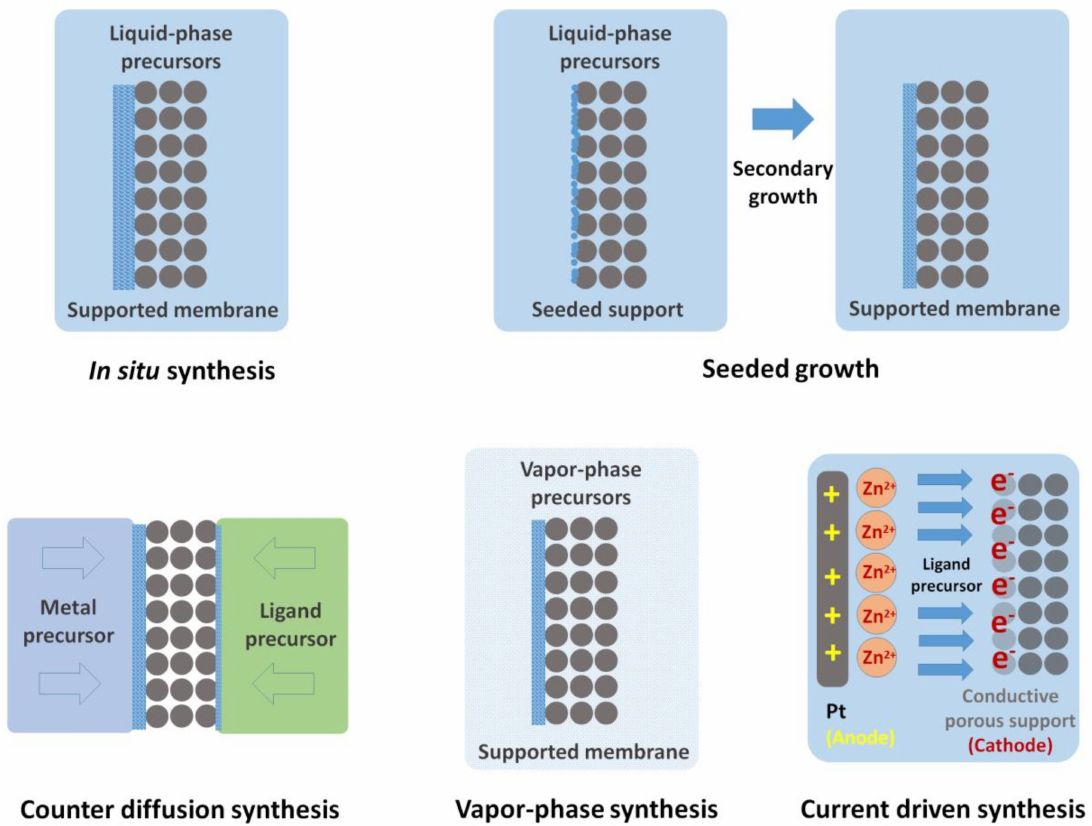
Figure 3. Schematic of the methods developed for the synthesis of supported ZIF